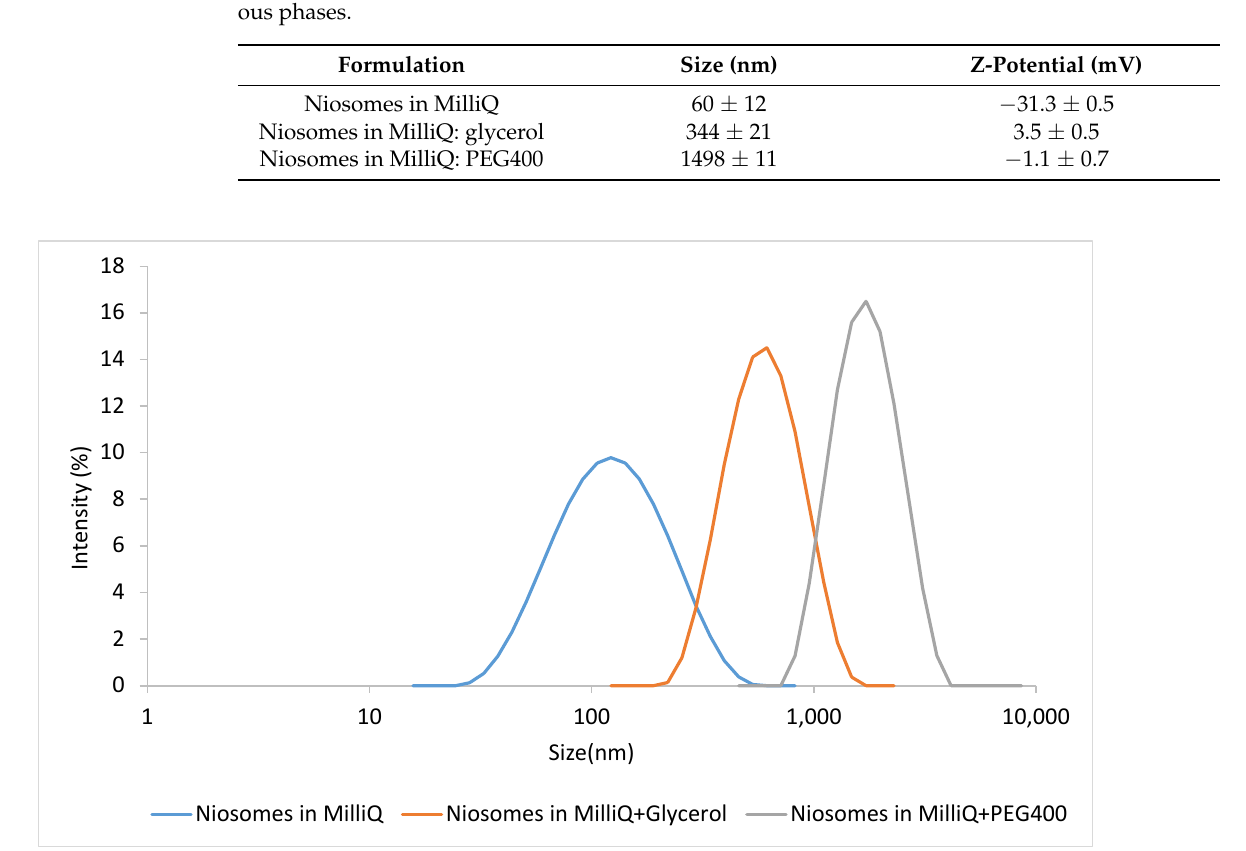
Figure 2. Size distribution of niosomes referring to the intensity, in MilliQ water, in mixture of MilliQ water and glycerol and in mixture of MilliQ water and